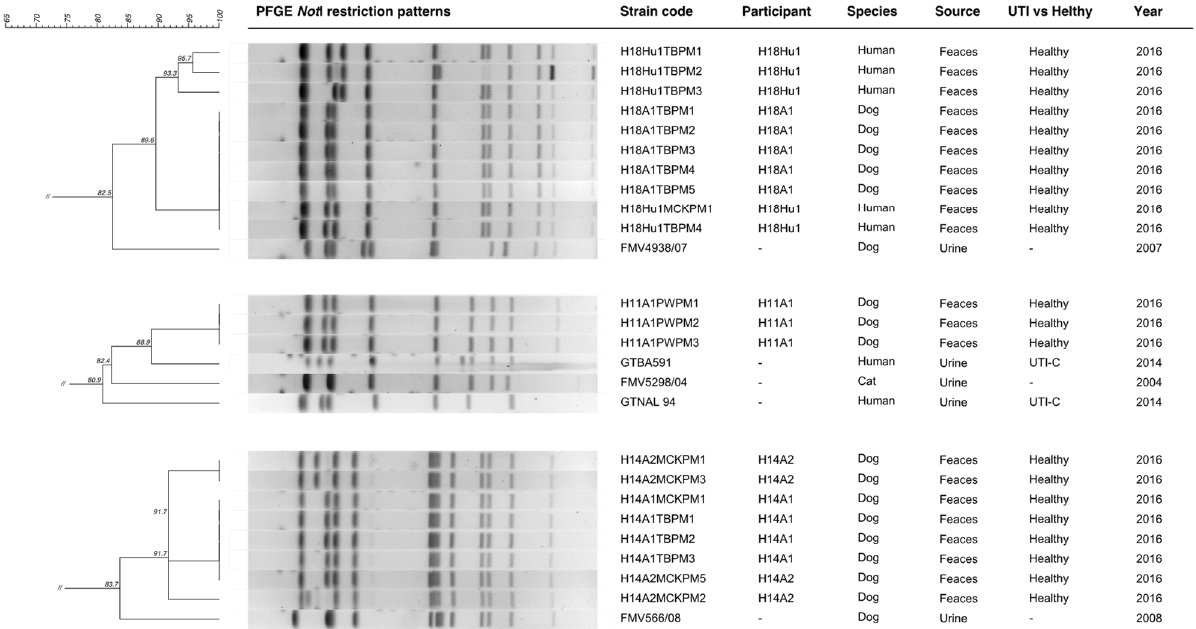
Figure 3. Clusters containing fecal P. mirabilis strains and clinical P. mirabilis strains from UTI. UTI-C, community patient with UTI; UTI-H, hospitalized patient with UTI.